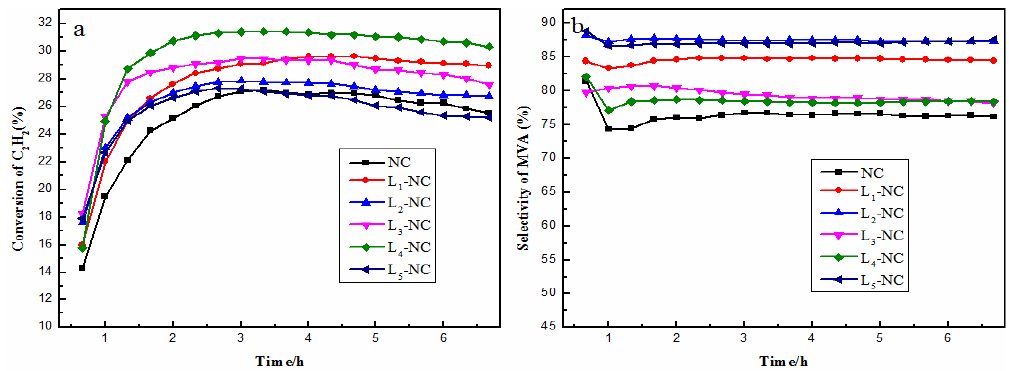
Figure 1. ( a ) Conversion of C 2 H 2 and ( b ) selectivity to monovinylacetylene (MVA) in acetylene dimerization over NC and L -NC. (Reaction conditions: Space velocity of acetylene 105 h −1 , reaction temperature 80 °C, 3% of L 1 – L 5 ).